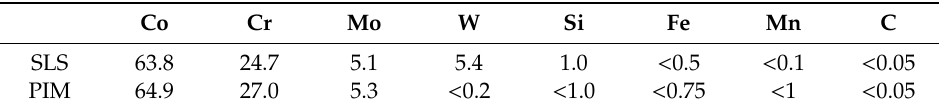
Table 1. Chemical composition of the powder (wt.%), used for Co-Selective Laser Sintering (Co-SLS) and Co-Powder Injection Molding (Co-PIM)